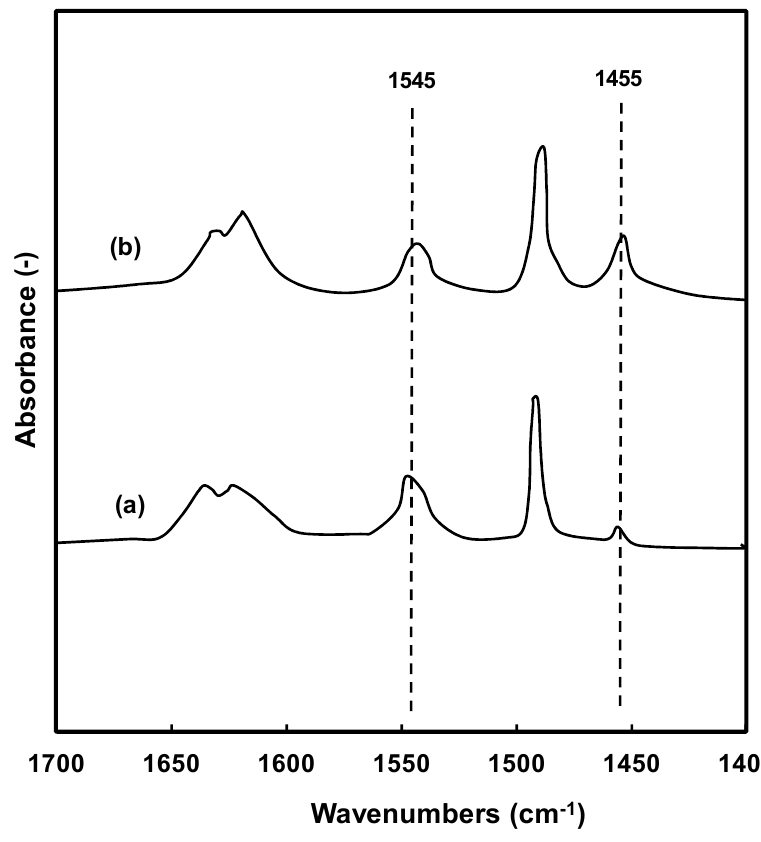
Figure 4. FT-IR spectra of pyridine adsorbed on the ( a ) HZ(25) and ( b ) HY(3) zeolites at room temperature and desorbed at 150 °C.